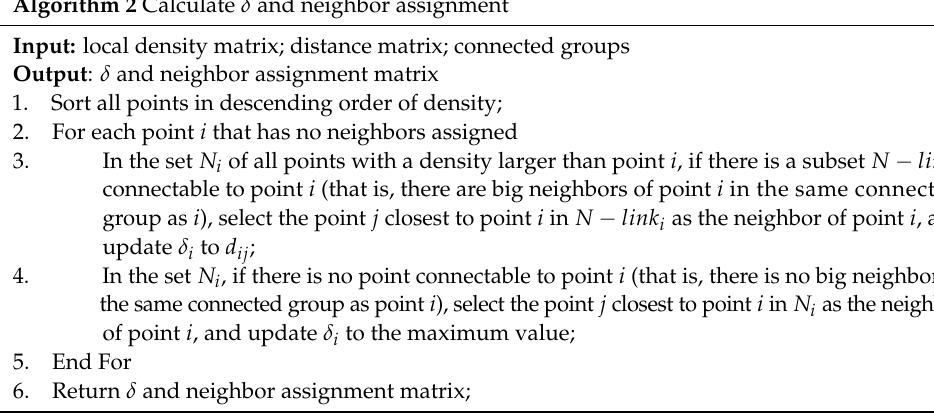
Algorithm 2 Calculate δ and neighbor assignment